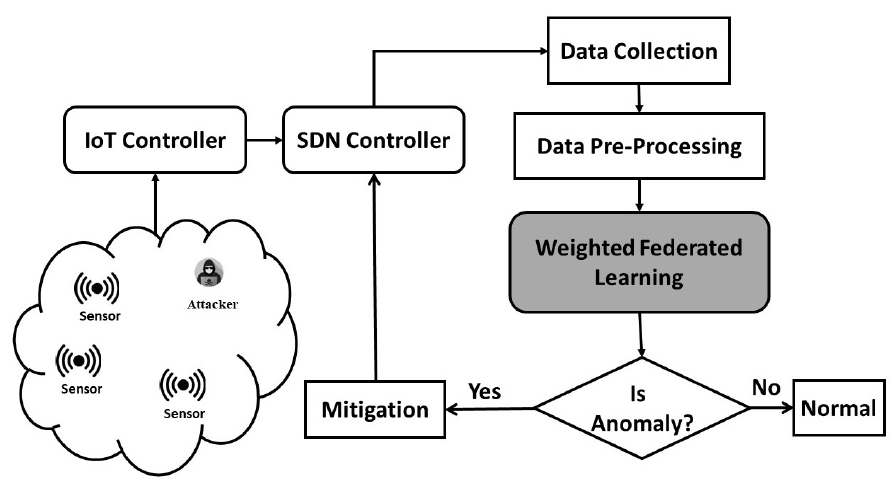
Figure 2. Proposed WFL-based model flow chart for SDN-based managed IoT networks.